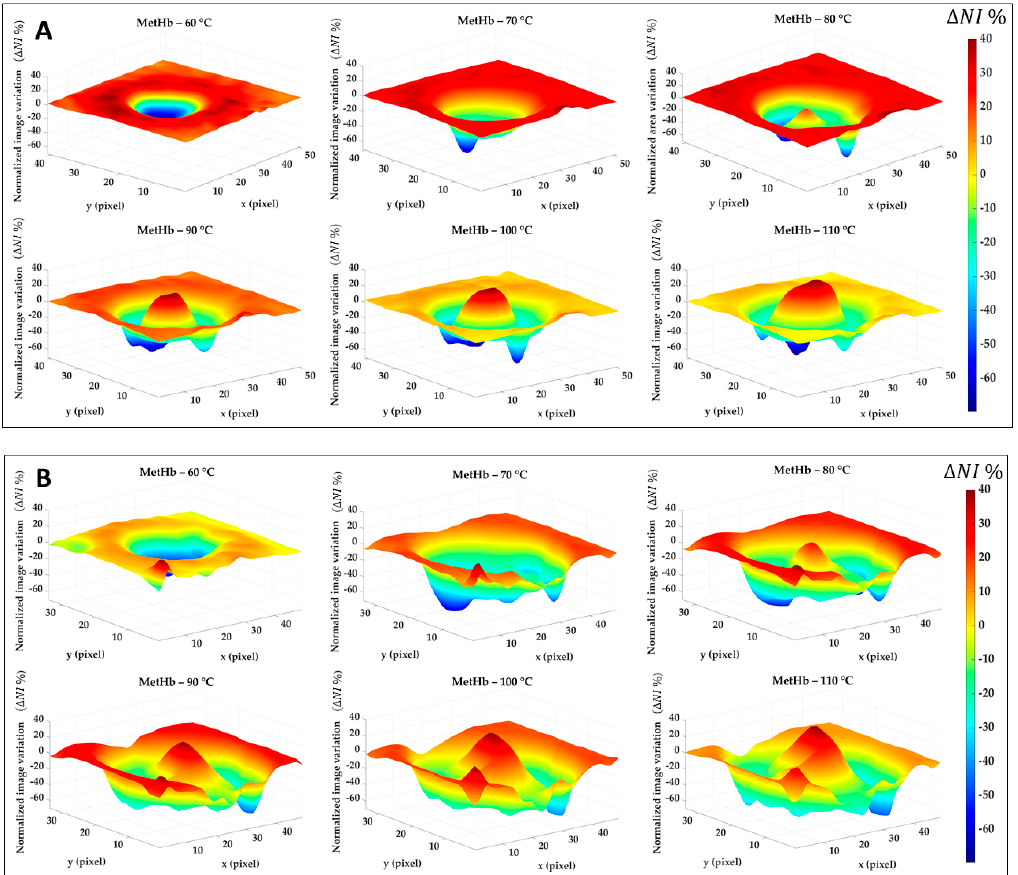
% ) in the MetHb spectral range for Test 1 ( A ) and Test 2 ( B ) %) in the MetHb spectral range for Test 1 ( A ) and Test 2 (cid:3284) i